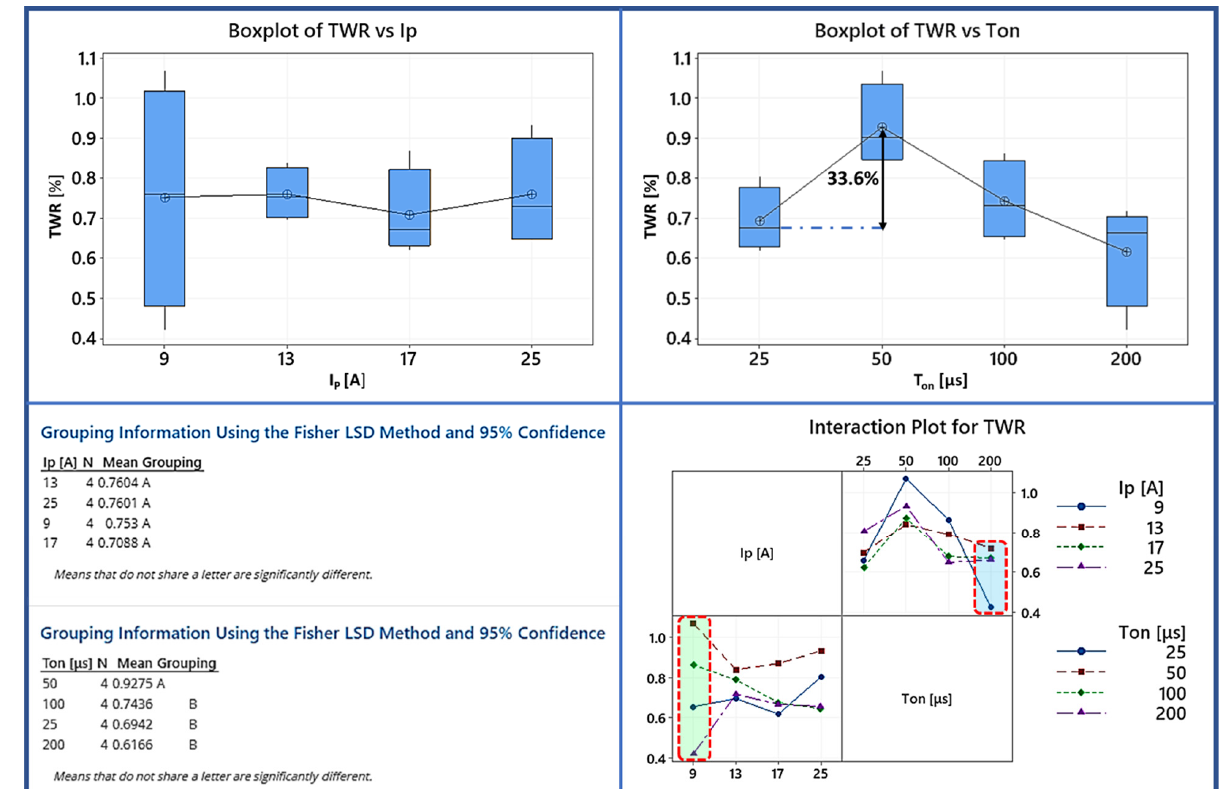
Figure 7. Box plot, interaction plot of TWR and the results of the Fisher statistically significant